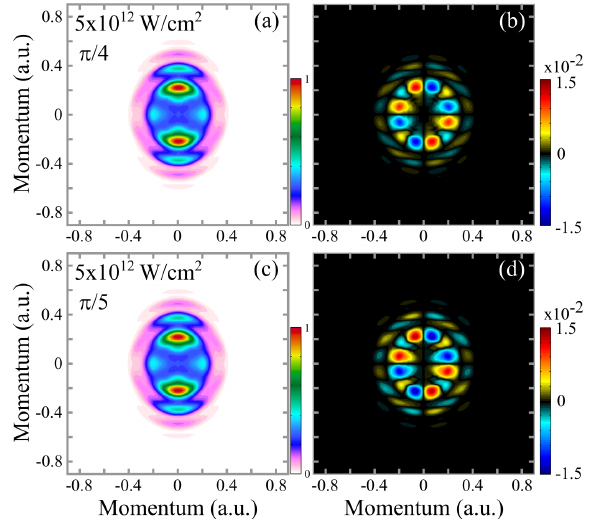
FIG. 8. Convergence check with respect to the number of random molecular orientations included in the TDSE calcula- tions. Symmetric (a) and antisymmetric (b) parts of the photo- electron momentum distribution obtained with an angular Euler spacing Δ α ¼ Δ β ¼ Δ γ ¼ π = 4 . Panels (c) and (d) are the counterparts of (a) and (b), respectively, obtained with Δ α ¼ Δ β ¼ Δ γ ¼ π = 5 . All other TDSE parameters are the same ¼ 200 a : u : , l ¼ 10 , and k ¼ in both calculations: r max max max 7 a : u : with two-color phase of φ ¼ 0